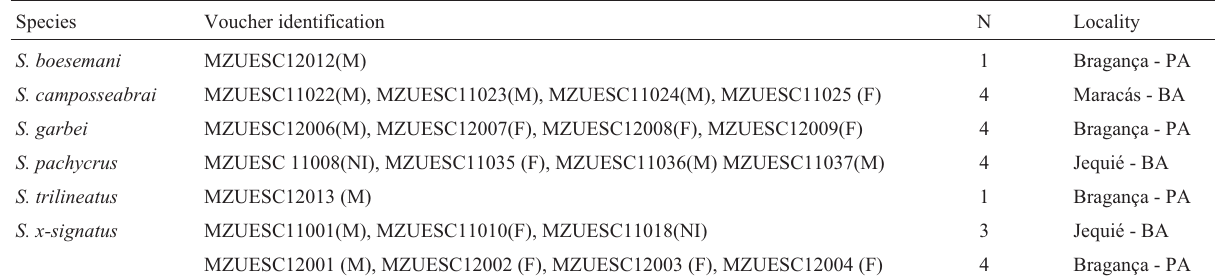
Table 1 - Analyzed species, number and sex of specimens (N) and collection site. Species Voucher identification